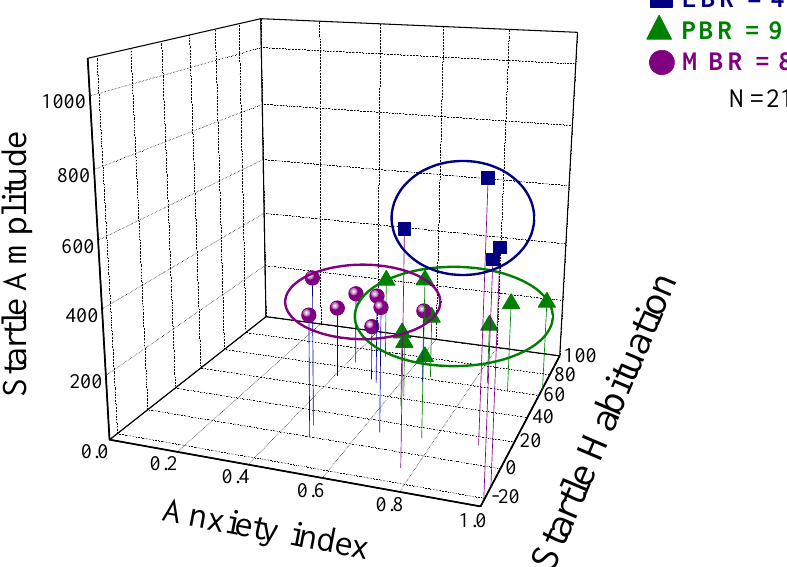
Figure 2. Behavioral responses to PSS observed in the MPST experiment. Rats were exposed to PSS. Their behavior was assessed 7 days later in an elevated plus maze (EPM) test and then one hour later in an acoustic startle response (ASR) test. Data are displayed in three dimensions: The X-axis represents time spent in the open arms (min) in the EPM test. The Y-axis represents acoustic startle amplitude in the ASR test, and the amplitude of the whole-body startle to an acoustic pulse was defined as the average of 100 one-millisecond accelerometer readings collected from pulse onset. The Z-axis represents startle habituation (percentage) in the ASR test. Rats were grouped by their behavioral responses according to the cutoff behavioral criteria (CBC) model (see Methods) as having either an extreme behavioral response (EBR) to PSS (i.e., PTSD-phenotype), a partial behavioral response (PBR) or a minimal behavioral response (MBR). Squares represent the EBR group that exhibited a significant degree of anxiety-like and avoidant behaviors on the elevated plus-maze and a pattern of exaggerated startle responses with significantly reduced habituation 7 days after PSS exposure. Squares represent the EBR group; Triangles represent the PBR group; Circles represent the MBR group [20,21].